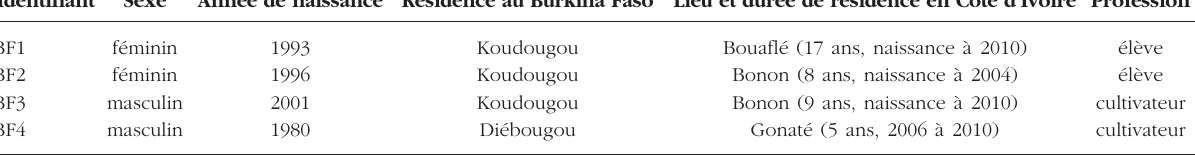
Tableau II. – Description des quatre trypanosomés dépistés passivement au Burkina